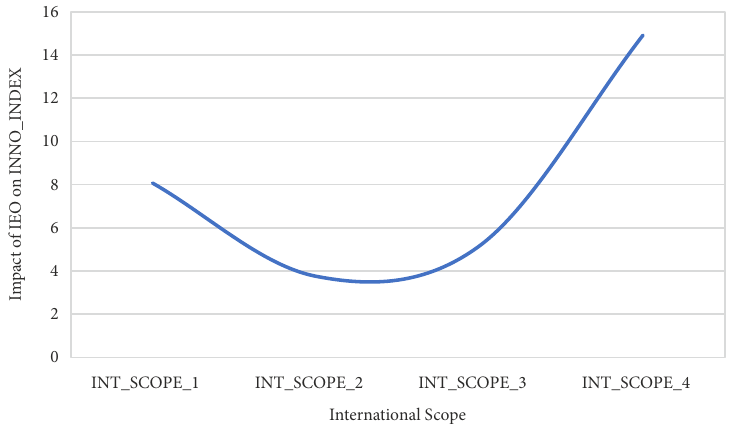
Figure 3. Influence of entrepreneurial orientation on innovation for groups of enterprises with different scopes of internationalisation (source: own elaboration based on a survey ( n